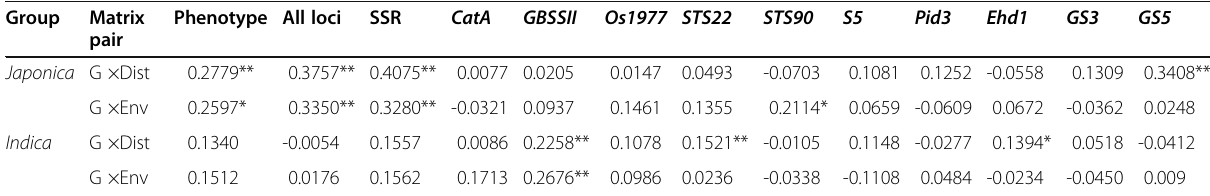
G genetic distance; Dist geographic distance; Env environmental distance. * P <0.05; ** P